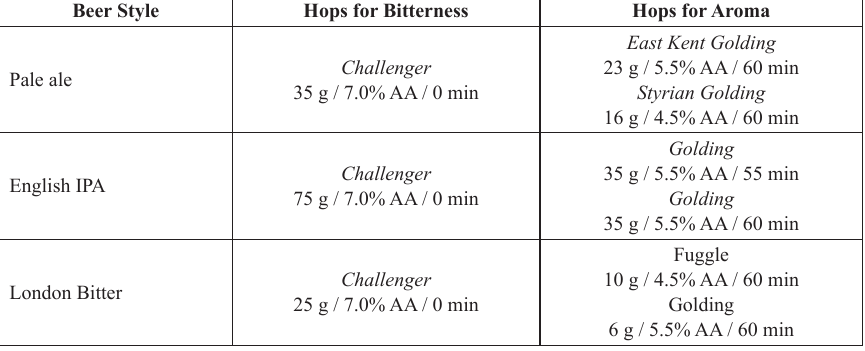
Table 2. Common hops in some beer styles. Amount (for 25–27 L of beer), alpha-acid content (AA), time for additions and international bitterness units (IBU)